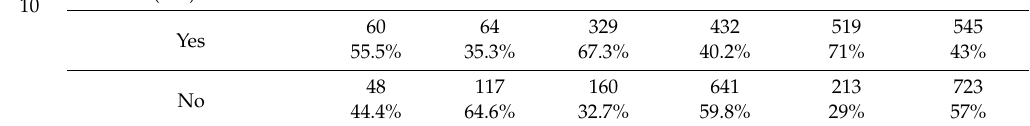
Confidence Interval (CI) with p -Values, n = 3406, Model II after Multiple